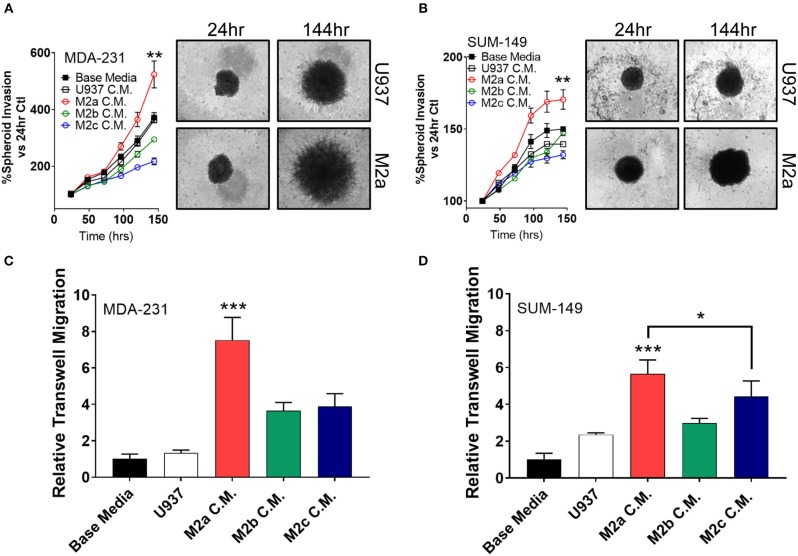
3D cell invasion assays confirm M2a TAMs as the greatest enhancer of breast cancer cell invasion. (A) Results from spheroid invasion assays in MDA-231 cells display a strong response to M2a conditioned media (C.M.). (B) Spheroid invasion results from the inflammatory TNBC cell line, SUM-149. Statistical significance in (A,B) is displayed as the 144 h time point compared against all other 144 h time points. (C,D) Results from 3D transwell migration confirm M2a conditioned media (red) enhances MDA-MB-231 (C) and SUM-149 (D) cancer cell invasion. All results are compiled from ≥2 independent experiments; Statistical significance was determined by one-way ANOVA; error bars represent ± standard deviation; p-value is displayed as *p < 0.05, **p < 0.01, ***p < 0.001.